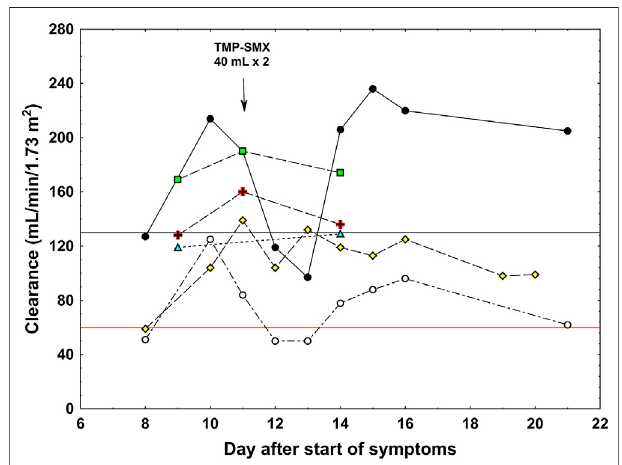
FIGURE 2 | Clearance values in a patient with augmented renal clearance. Black circles: measured creatinine clearance, white circles: measured urea clearance, green triangles: iohexol clearance, yellow rhomboids:cystatin Cclearance, redcross: totalvancomycinclearance, green squares: free vancomycin clearance. The black horizontal line shows the limit for augmented renal clearance (130 ml/min/1.73 m 2 ) and the red horizontal line shows the upper normal reference for urea clearance (60 ml/ min/1.73 m 2 ). Arrow shows the dosage of trimethoprim – sulfamethoxazole